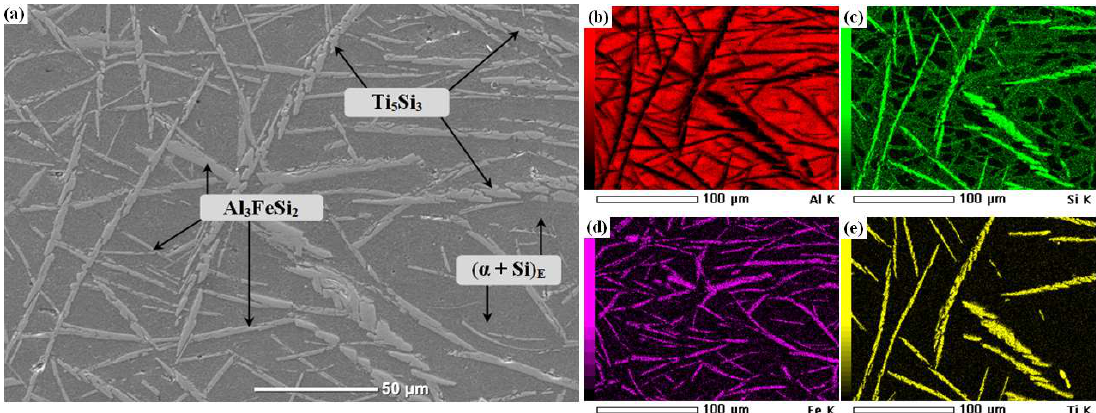
Figure 10. ( a ) Backscattered electron image of AlSiFe with 5 wt. % Ti alloy. Elemental mapping of ( b ) aluminum, ( c ) silicon, ( d ) iron, and ( e ) titanium. (α+Si) E = Eutectic.